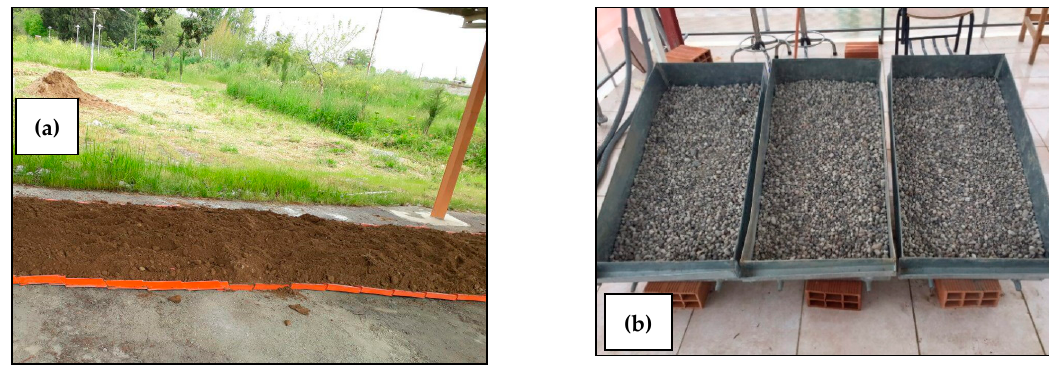
Figure 1. A view of dried soil in an open area ( a ) and the plots filled with pumice grains ( b ).